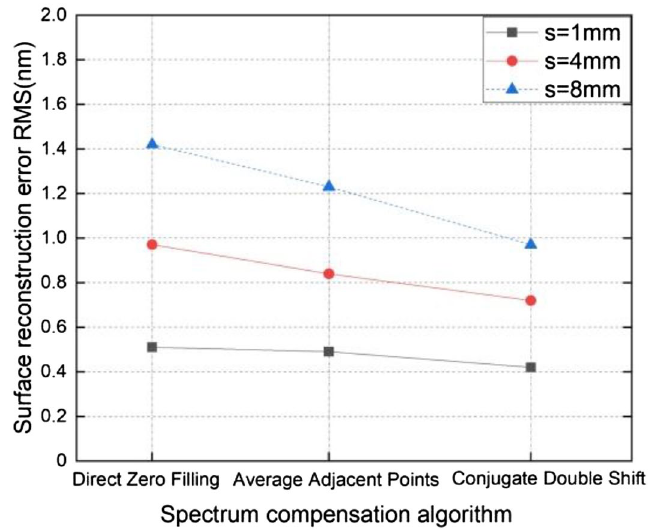
Figure 4. The influence of spectrum compensation on measurement results using various shift